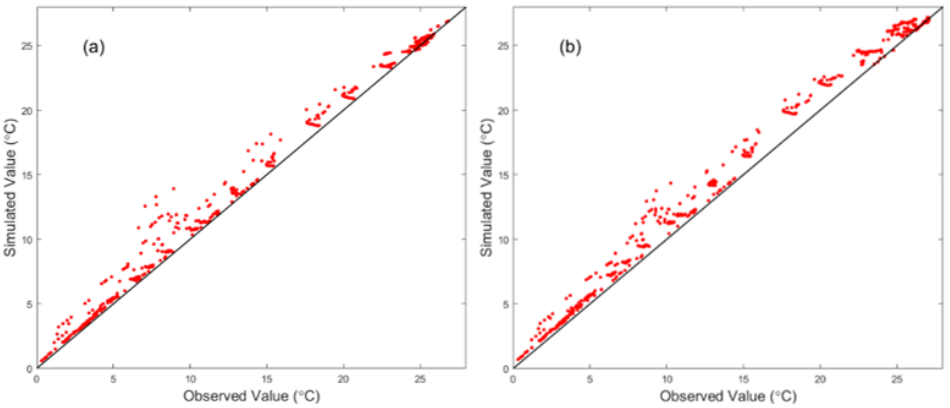
Figure 9. Comparison of simulated and observed values of vertical data in ideal experiments I ( a ) and II ( b ), the red dots denote interpolated observations.